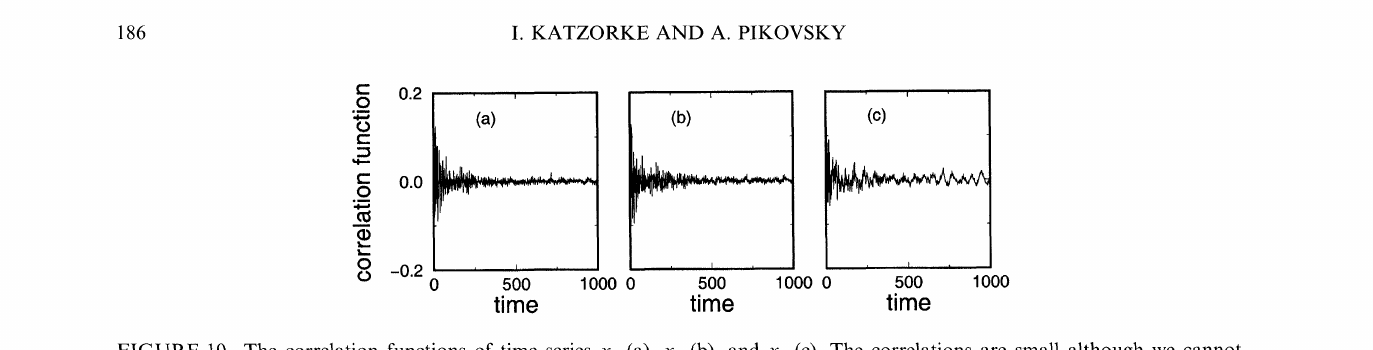
FIGURE 10 The correlation functions of time series xl (a), X (b), and x3 (c). The correlations are small although we cannot conclude that they vanish for large times.